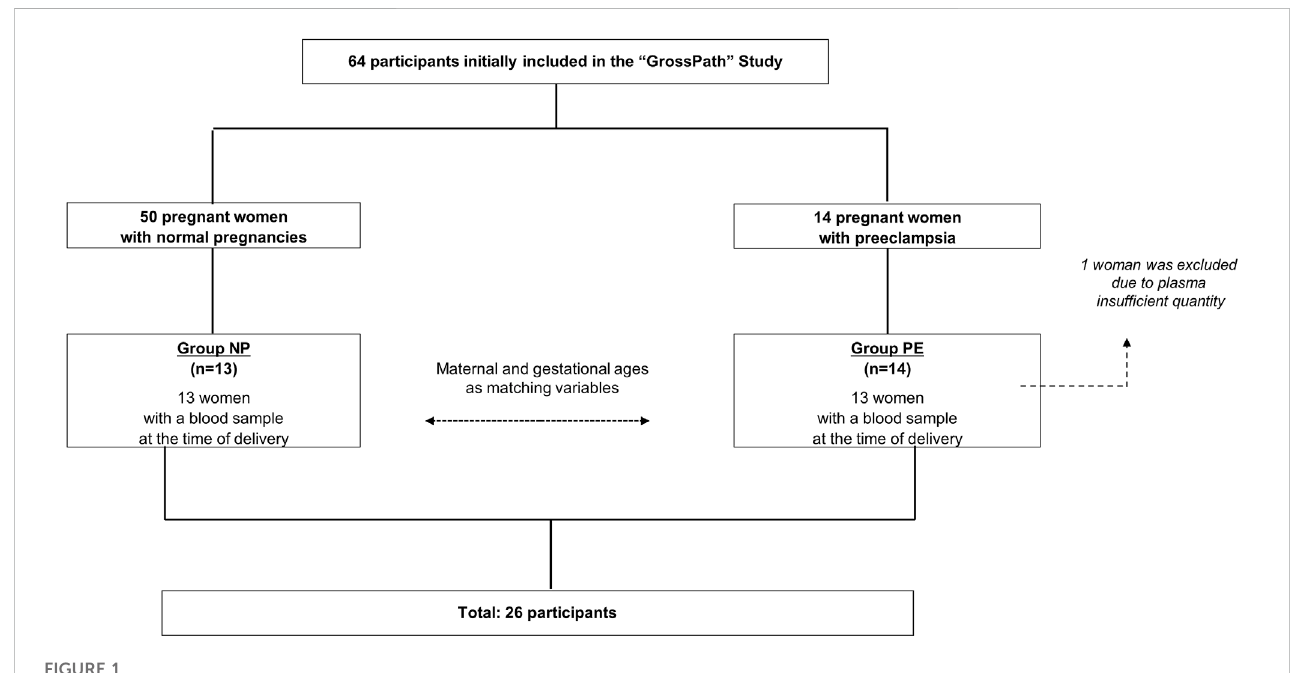
FIGURE 1 Participant fl